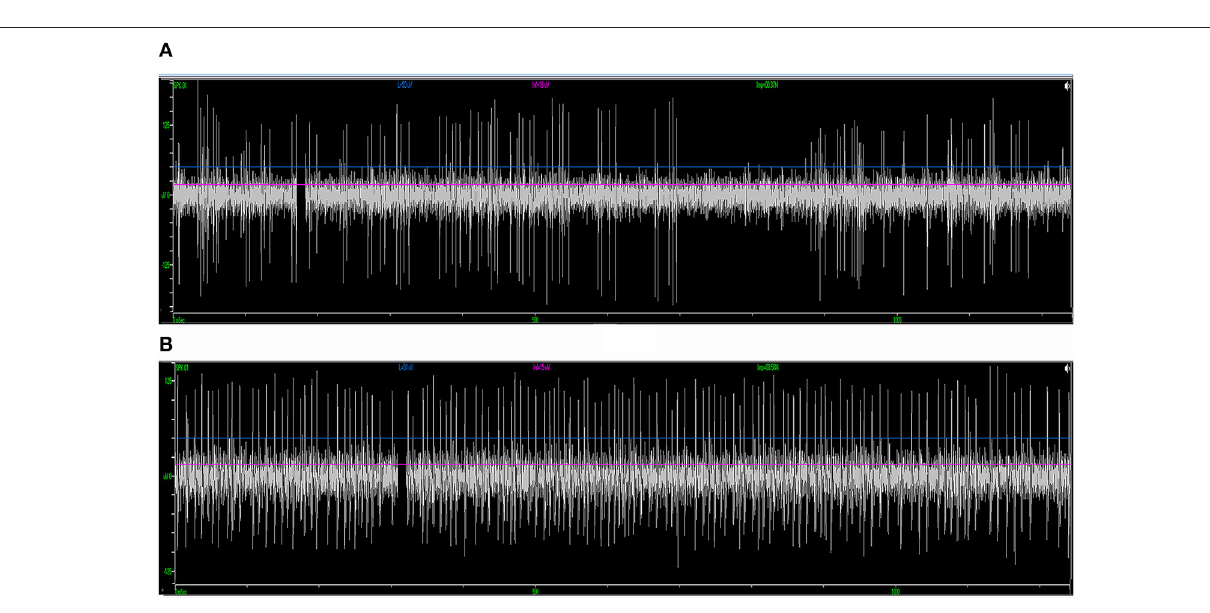
FIGURE 4 | Examples of standard STN and SNr signal in intraoperative microelectrode recording. (A) The typical STN signal is highlighted with a higher background noise level and irregularly firing neurons. (B) The SNr signal is featured by a lower background noise level with neurons that spike more regularly and frequently. STN, subthalamic nucleus; SNr, substantia